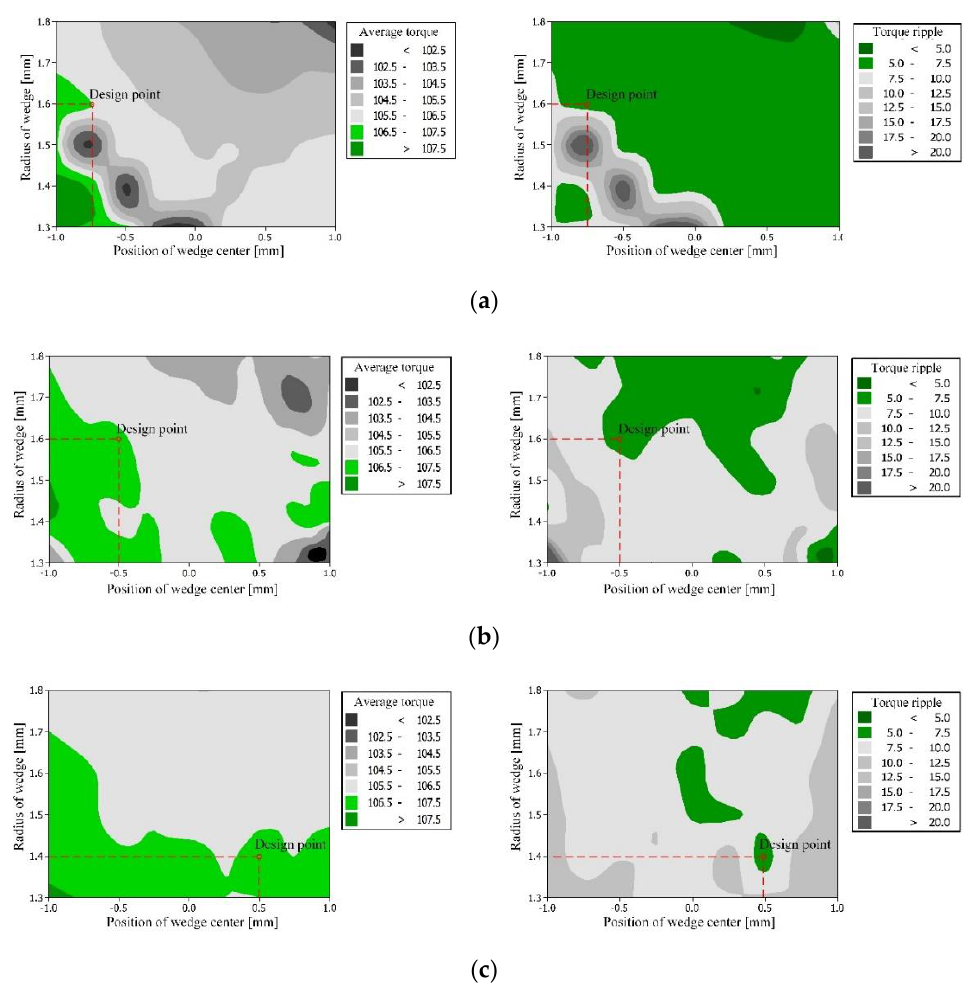
Figure 10. Contour plot of average torque and torque ripple characteristics by wedge skew param- eter by 3D FEA: ( a ) 3 layers; ( b ) 4 layers; ( c ) 5 layers. by 3D FEA: ( a ) 3 layers; ( b ) 4 layers; ( c ) 5